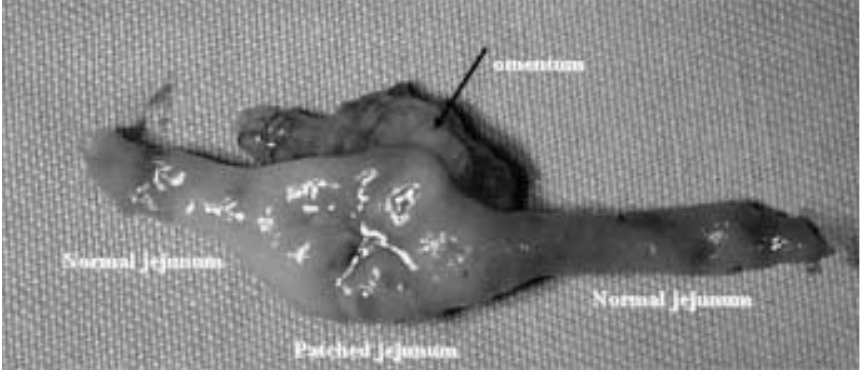
Circumference signif- icantly increased in the patched bowel in contrast to normal bowel; ‡ (p <0.001): I, II, III vs. I, II, III. However, circumfer- ence of the patched bowel was markedly lower in 4 month rats compared to the other